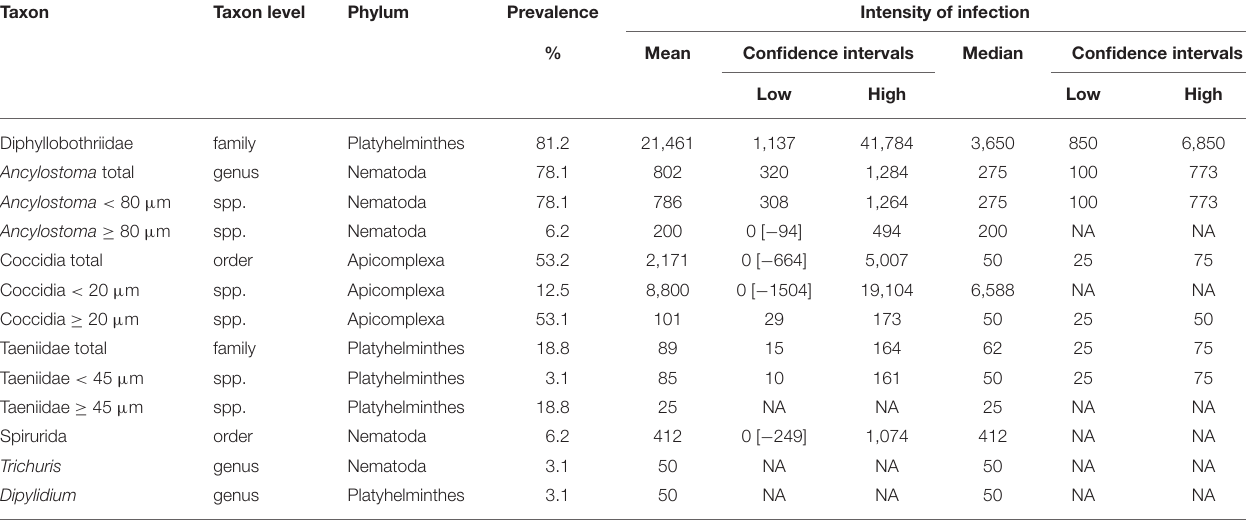
TABLE 2 | The intensity of infection in terms of parasite egg or oocyst counts per g feces from fecal samples ( n = 32) of spotted hyenas.